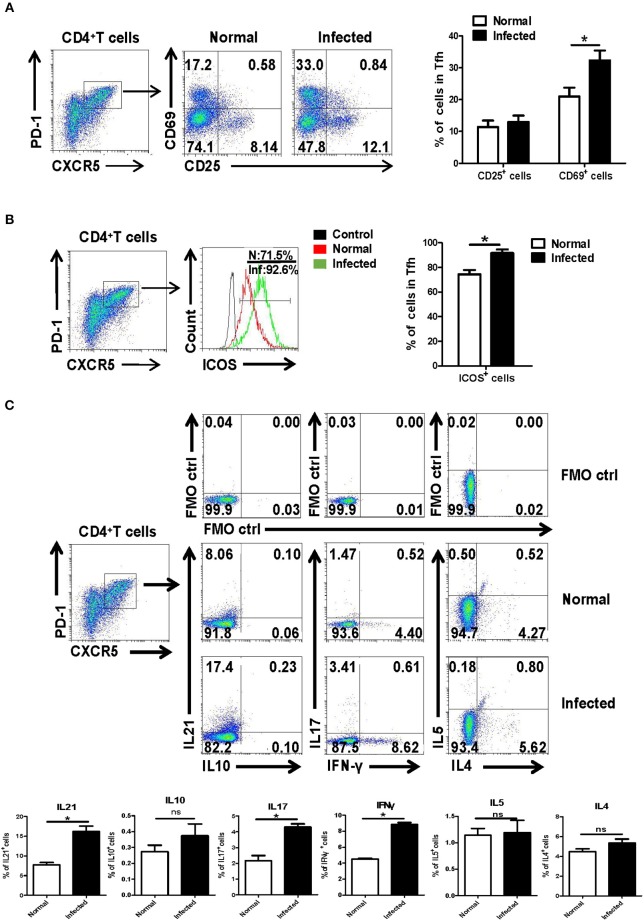
Activation associated molecules and cytokines expressing on Tfh cells. Single-cell suspensions of spleens were isolated from normal and infected mice. The expression of CD25 and CD69 on Tfh cells was detected using cell surface staining. The expression of CD25, CD69 (A), and ICOS (B) was analyzed using FCM; average expression of CD25, CD69, and ICOS was calculated from FACS data. Three independent experiments with similar results were performed and mean± SEM values of six samples pooled from three experiments are shown. *P < 0.05, compared with the controls; unpaired t-tests were used. (C) Single-cell suspensions of spleen cells from normal and S. japonicum infected mice were stimulated with or without PMA and ionomycin. Expressions of IL-21, IL-10, IL-17, IFN-γ, IL-4, and IL-5 were detected in Tfh cells by FACS analysis. Numbers in quadrants are percentages of cells in each expression phenotype (n = 5 mice per group). A representative of two independent experiments is shown. *P < 0.05, compared with the controls.